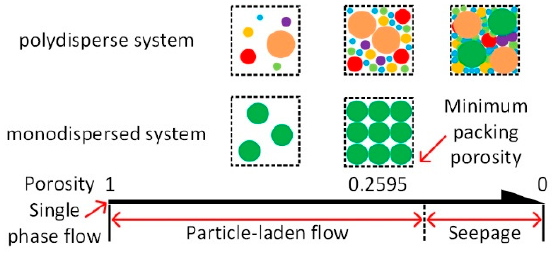
Figure 11. The differences between the monodisperse system and the polydisperse system.